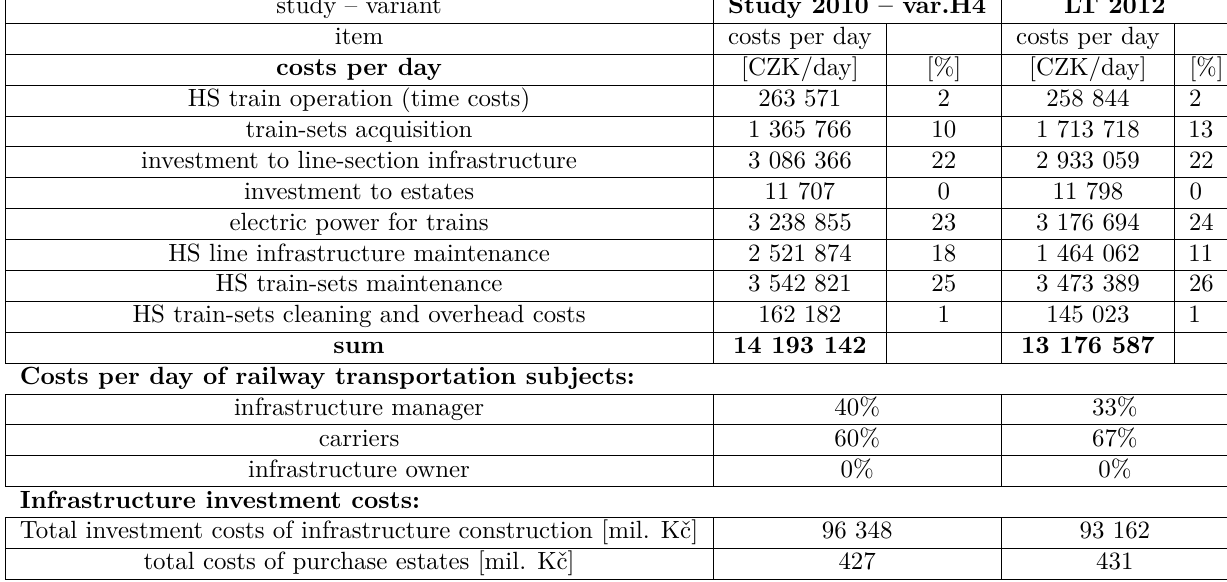
Table 2. Costs evaluation of variants.